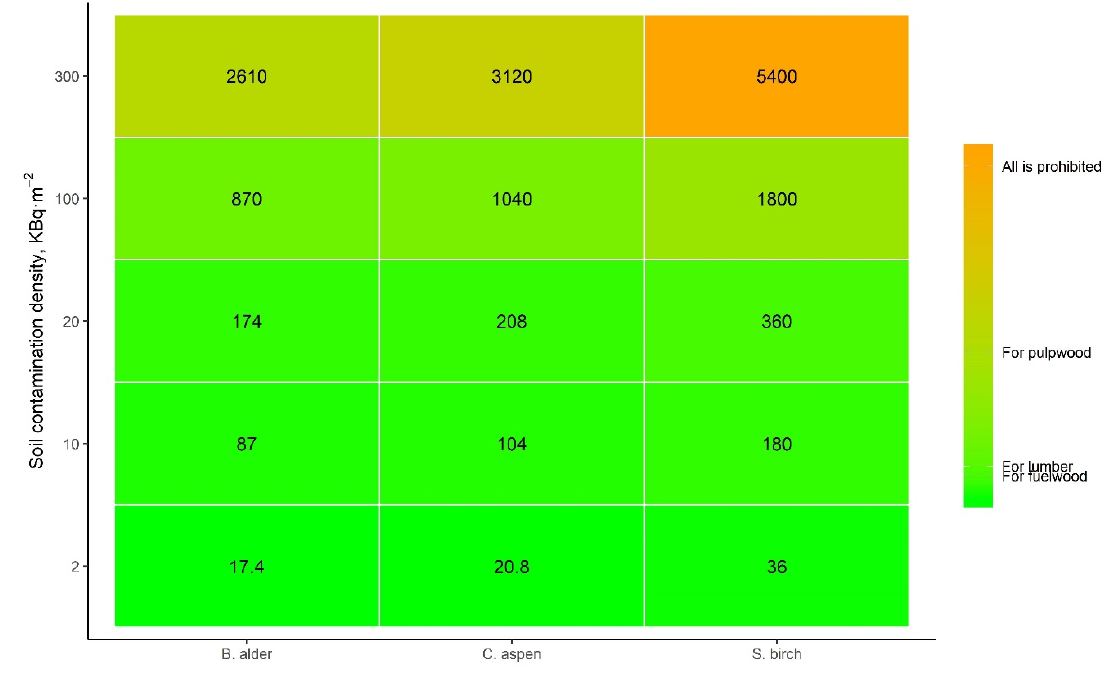
Figure 5. Heatmap of 90 Sr transition to the stemwood at different soil contamination (kBq m − 2 ) levels according to restrictions implemented in Russia. Only specific discrete values of the soil contamination density are given.